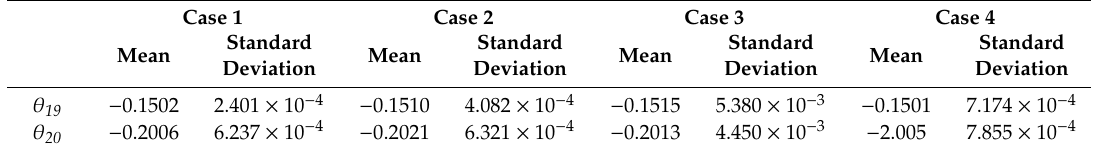
Table 3. The identified results of the model